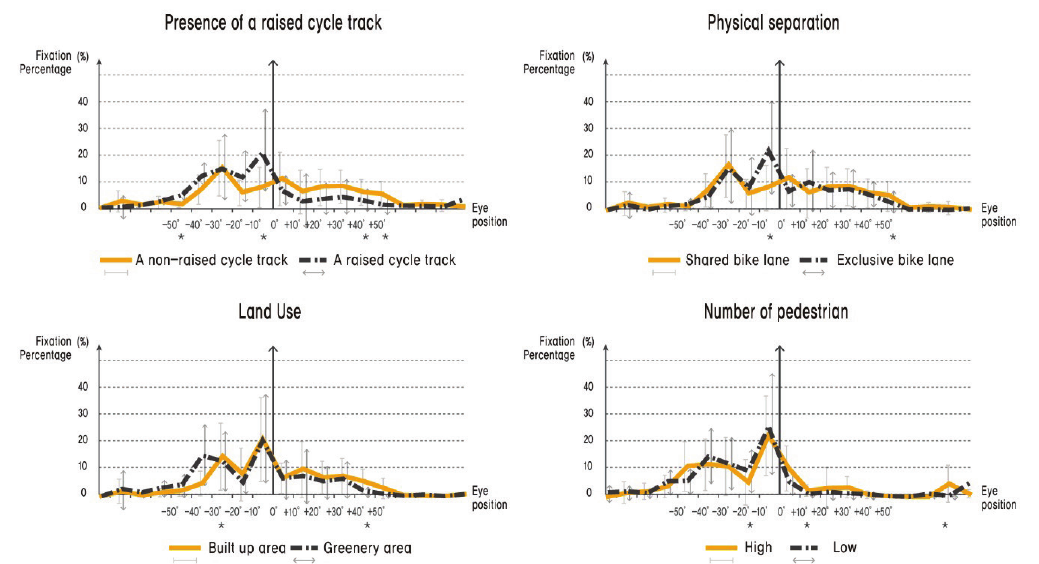
Figure 7. Horizontal spread of fixation duration (%) for the presence of a raised cycle track, physical separation, land use, number of pedestrian. And * presents to have significant